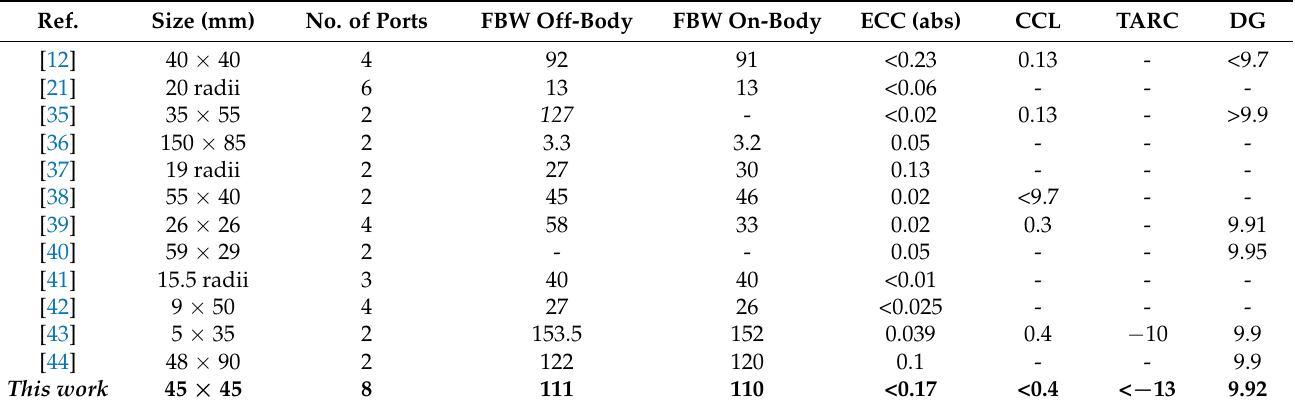
Table 2. Comparative